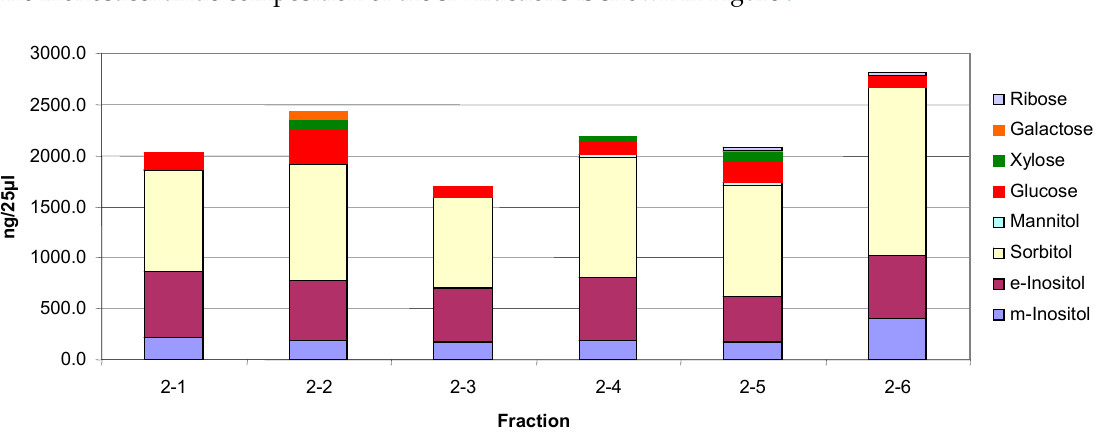
Figure 9. Monosaccharide composition of fractions.